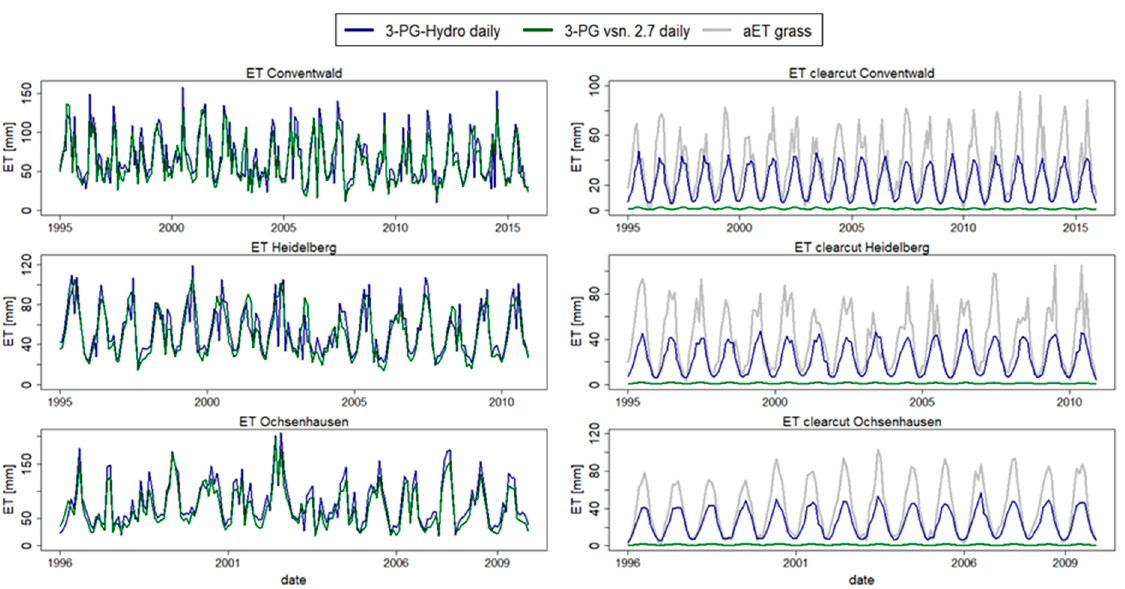
Figure A5. Evapotranspiration (mm × month − 1 ) simulations by 3-PG-Hydro and 3-PG vsn. 2.7 calculated with daily resolution and displayed as monthly sum. The three plots on the left show the ET simulation at all three stands. The plots on the right display the clear-cut simulation (0 trees × hectar − 1 ) for each stand. It is compared to observed actual evaporation of grassland at the site.